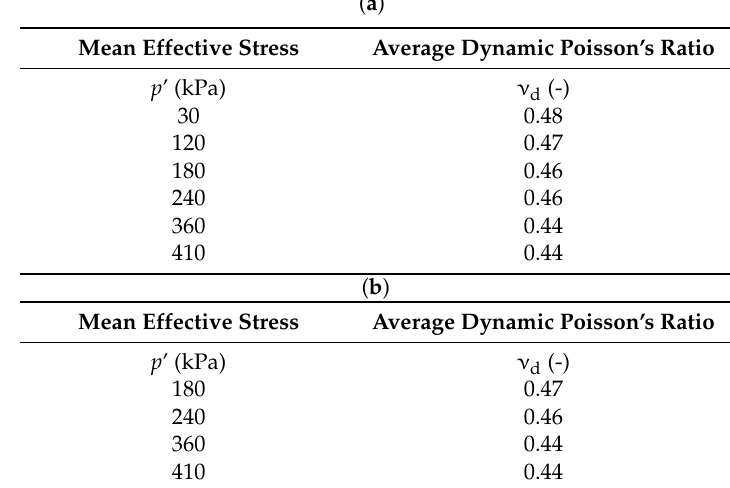
Table 3. Dynamic Poisson’s ratio for various mean effective stress levels. ( a ) Peak-to-peak method; ( b ) start-to-start